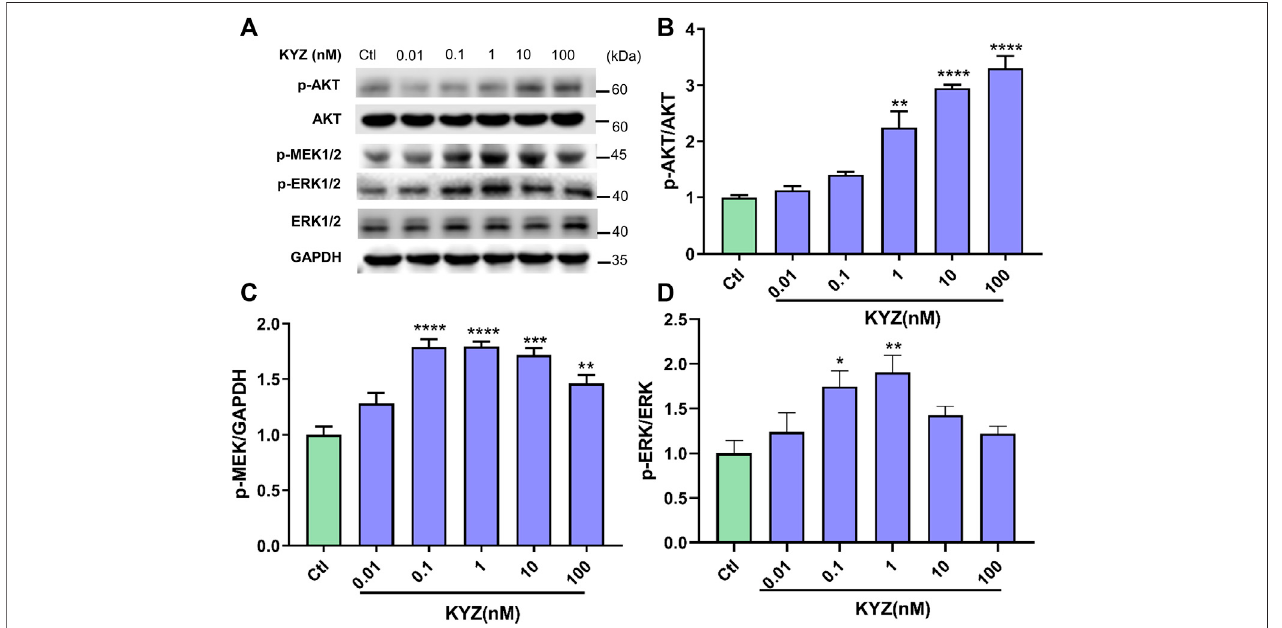
Frontiers in Pharmacology |